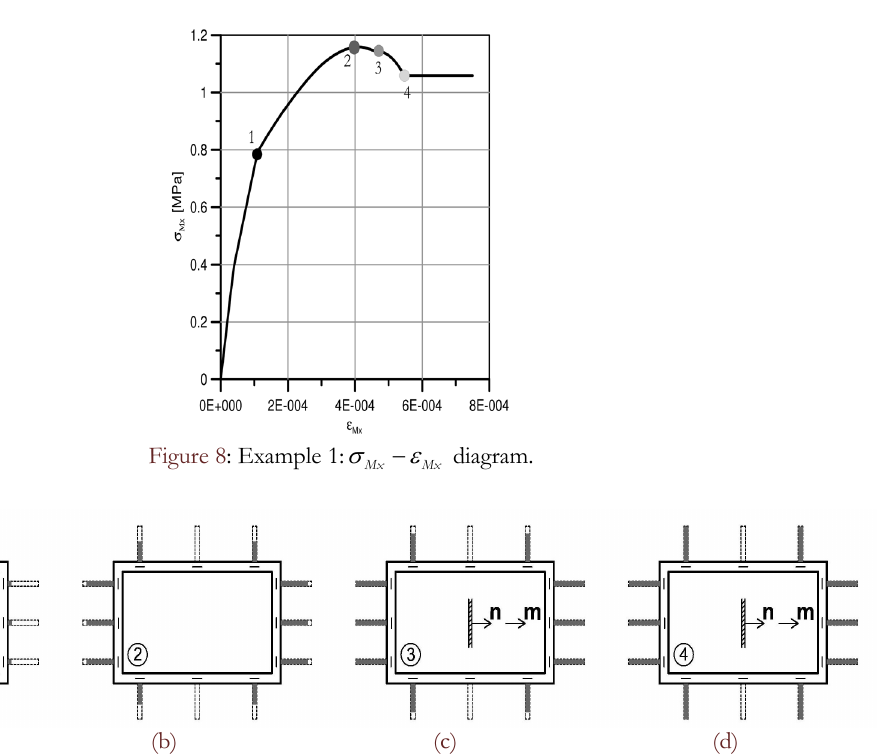
Figure 9: Example 1: plasticity evolution at interface Gauss points and results of localization at four stages indicated in Fig. 8.